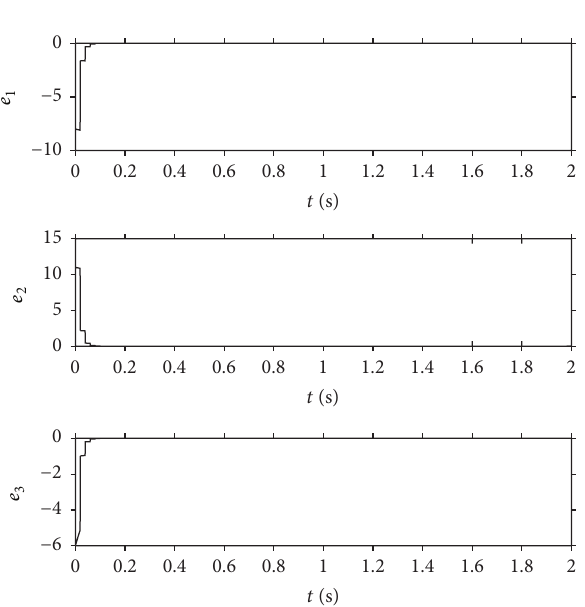
Figure 4: Time response of the error state variable in case